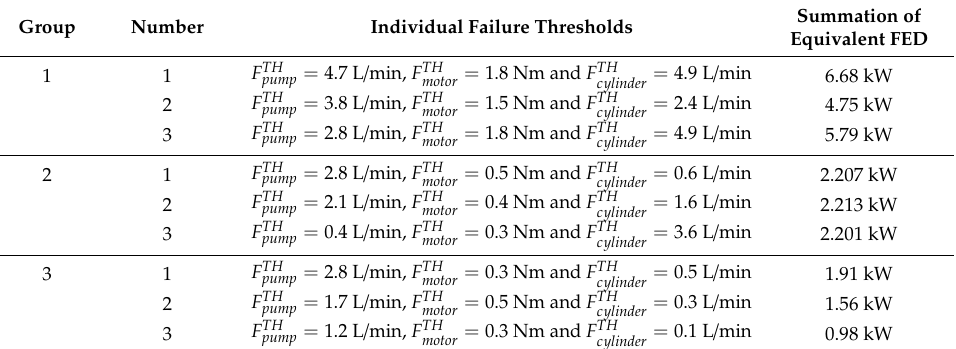
Table 2. Individual failure